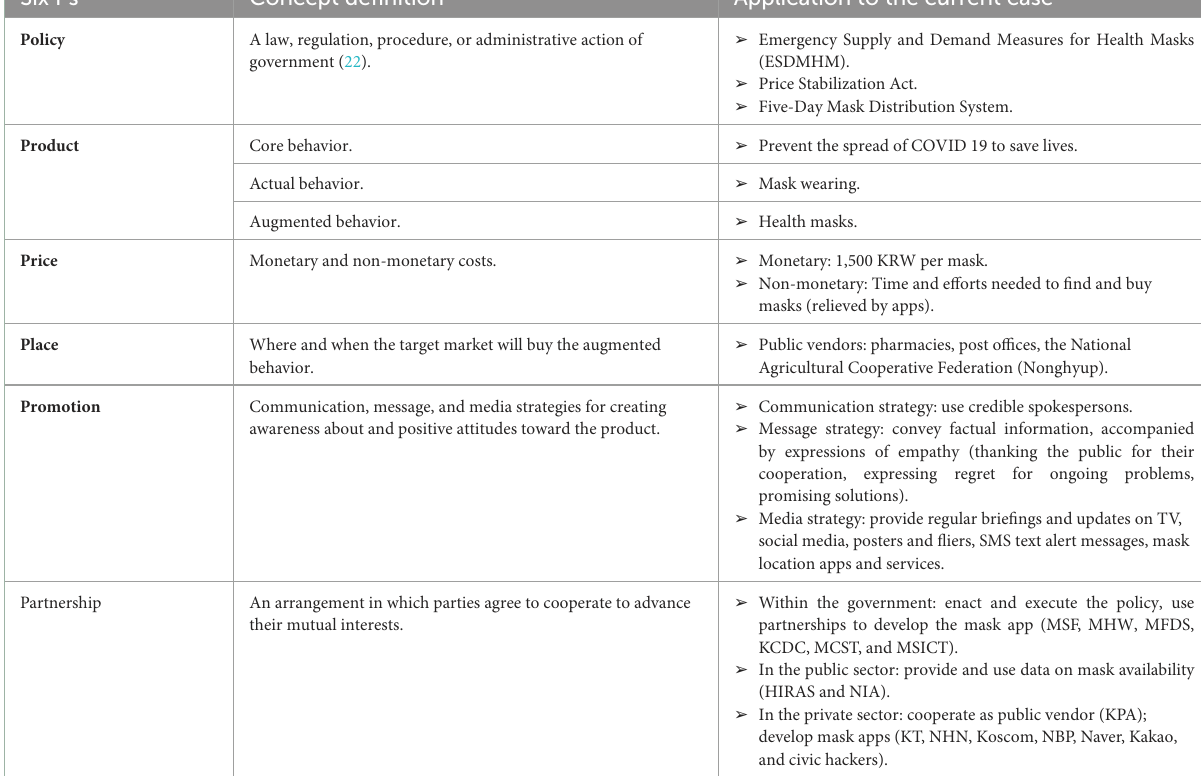
TABLE 1 Social marketing components. Six